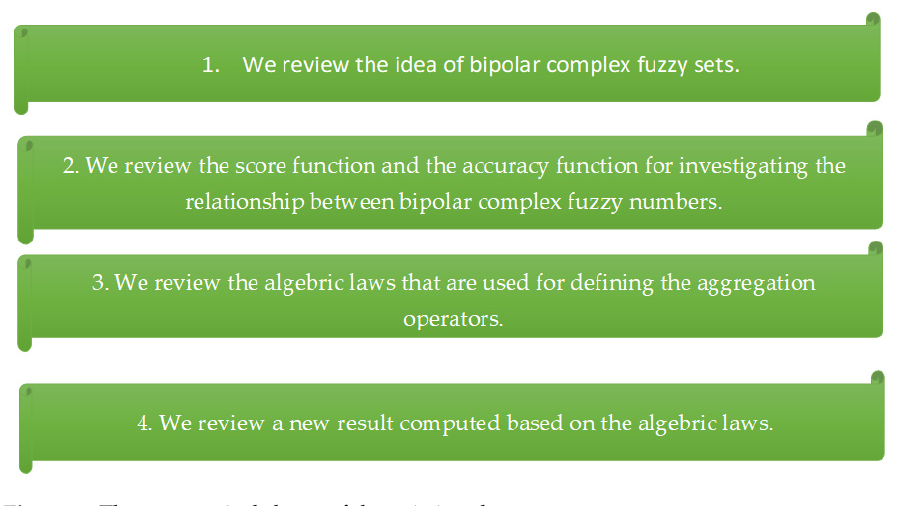
Figure 1. The geometrical shape of the existing theory.